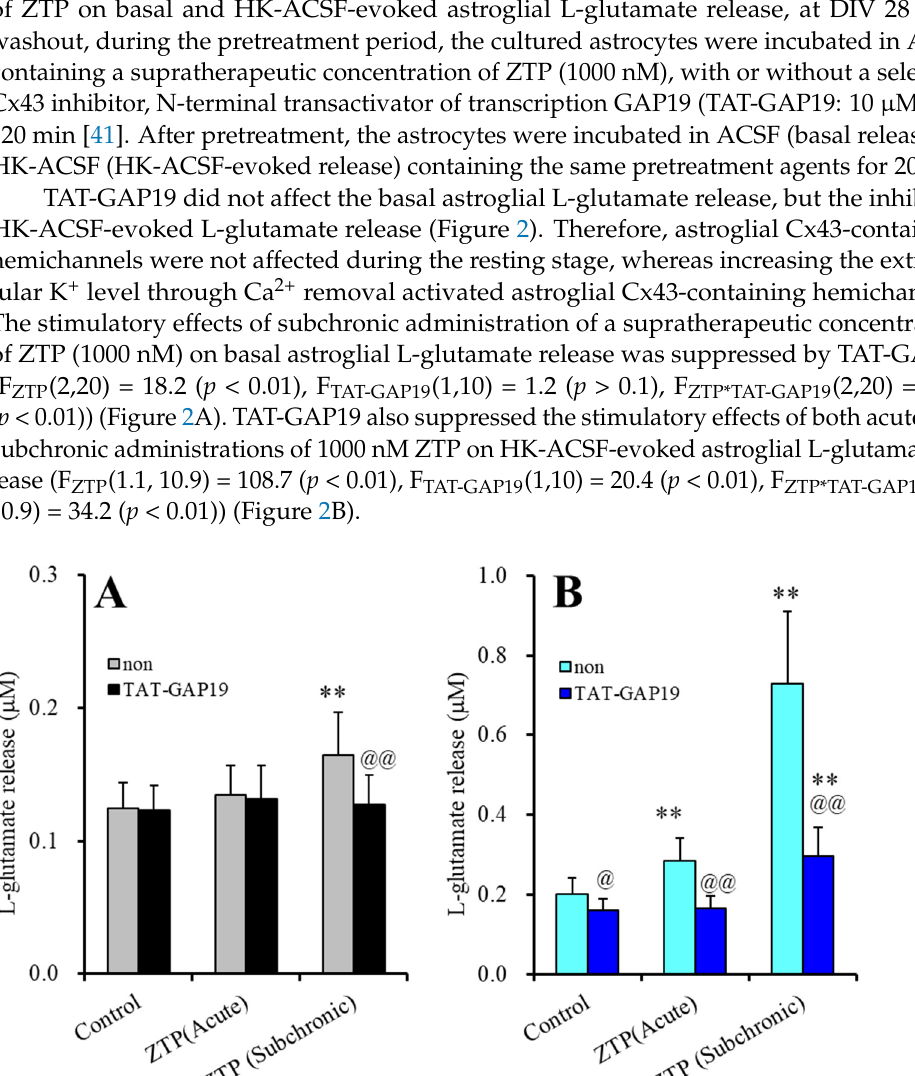
Figure 2. Effects of selective Cx43 inhibitor, N-terminal transactivator of transcription GAP19 (TAT-